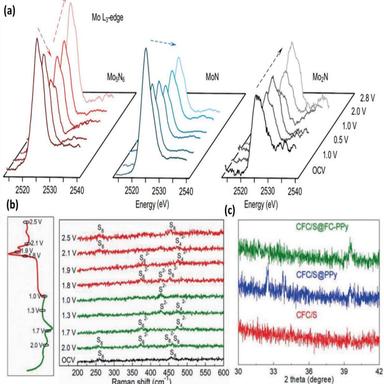
a) Ex-situ NEXAFS for the Mo-L3-edge of S/Mo5N6, S/MoN, and S/Mo2N during a discharge/charge process. b) cyclic voltammogram with the test potentials for analysis and the in-situ Raman spectra of CFC/S@FC-PPy, and c) ex-situ XRD patterns of sulfur cathodes in fully discharged state. Reprinted (adapted) with permission from Ref. . Copyright 2021 John Wiley & Sons.